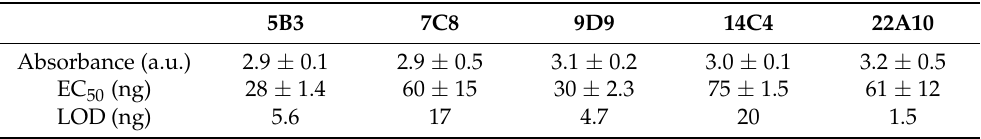
Table 1. Absorbance values of monoclonal antibodies with 300 ng of rhS100A9, EC 50 of the antibodies, and limit of detection (LOD) values of the